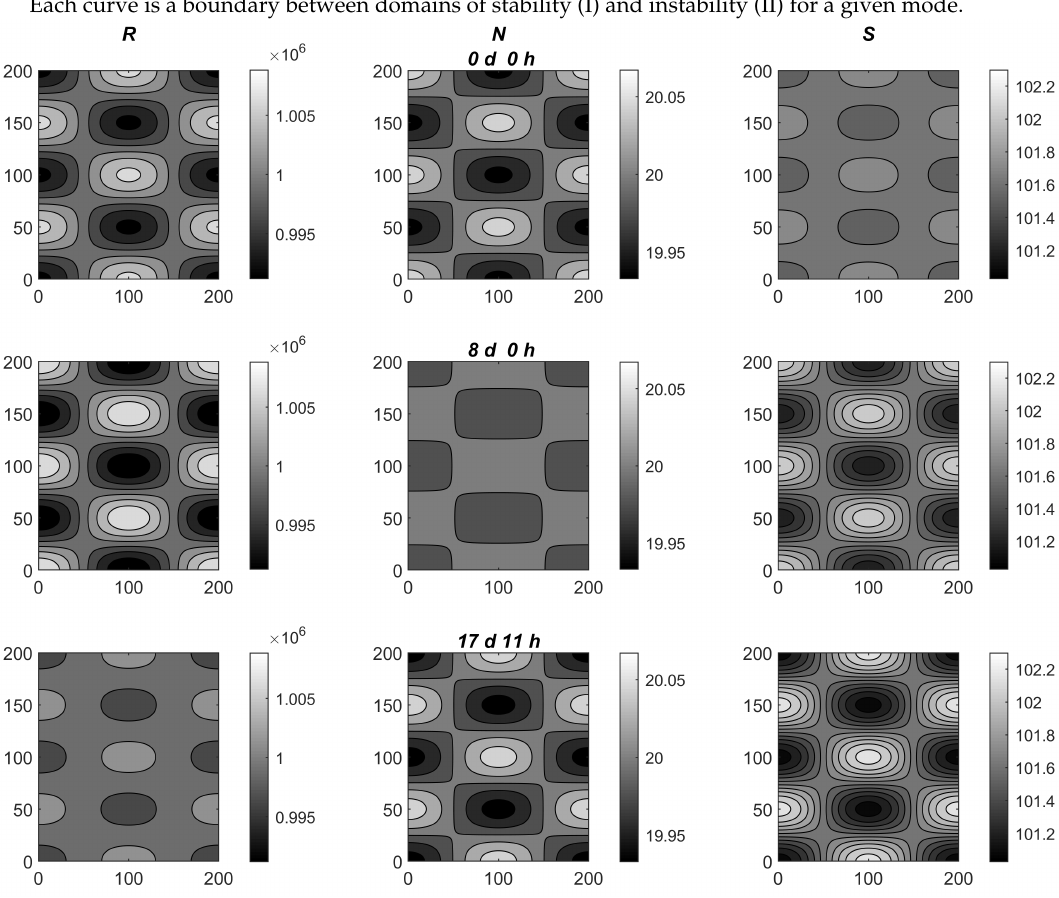
Figure A2. Snapshots of spatial distributions of the model variables for spatially-heterogeneous periodic dynamics emerging with excitation of mode ( 2,4 ) (point B in Figure